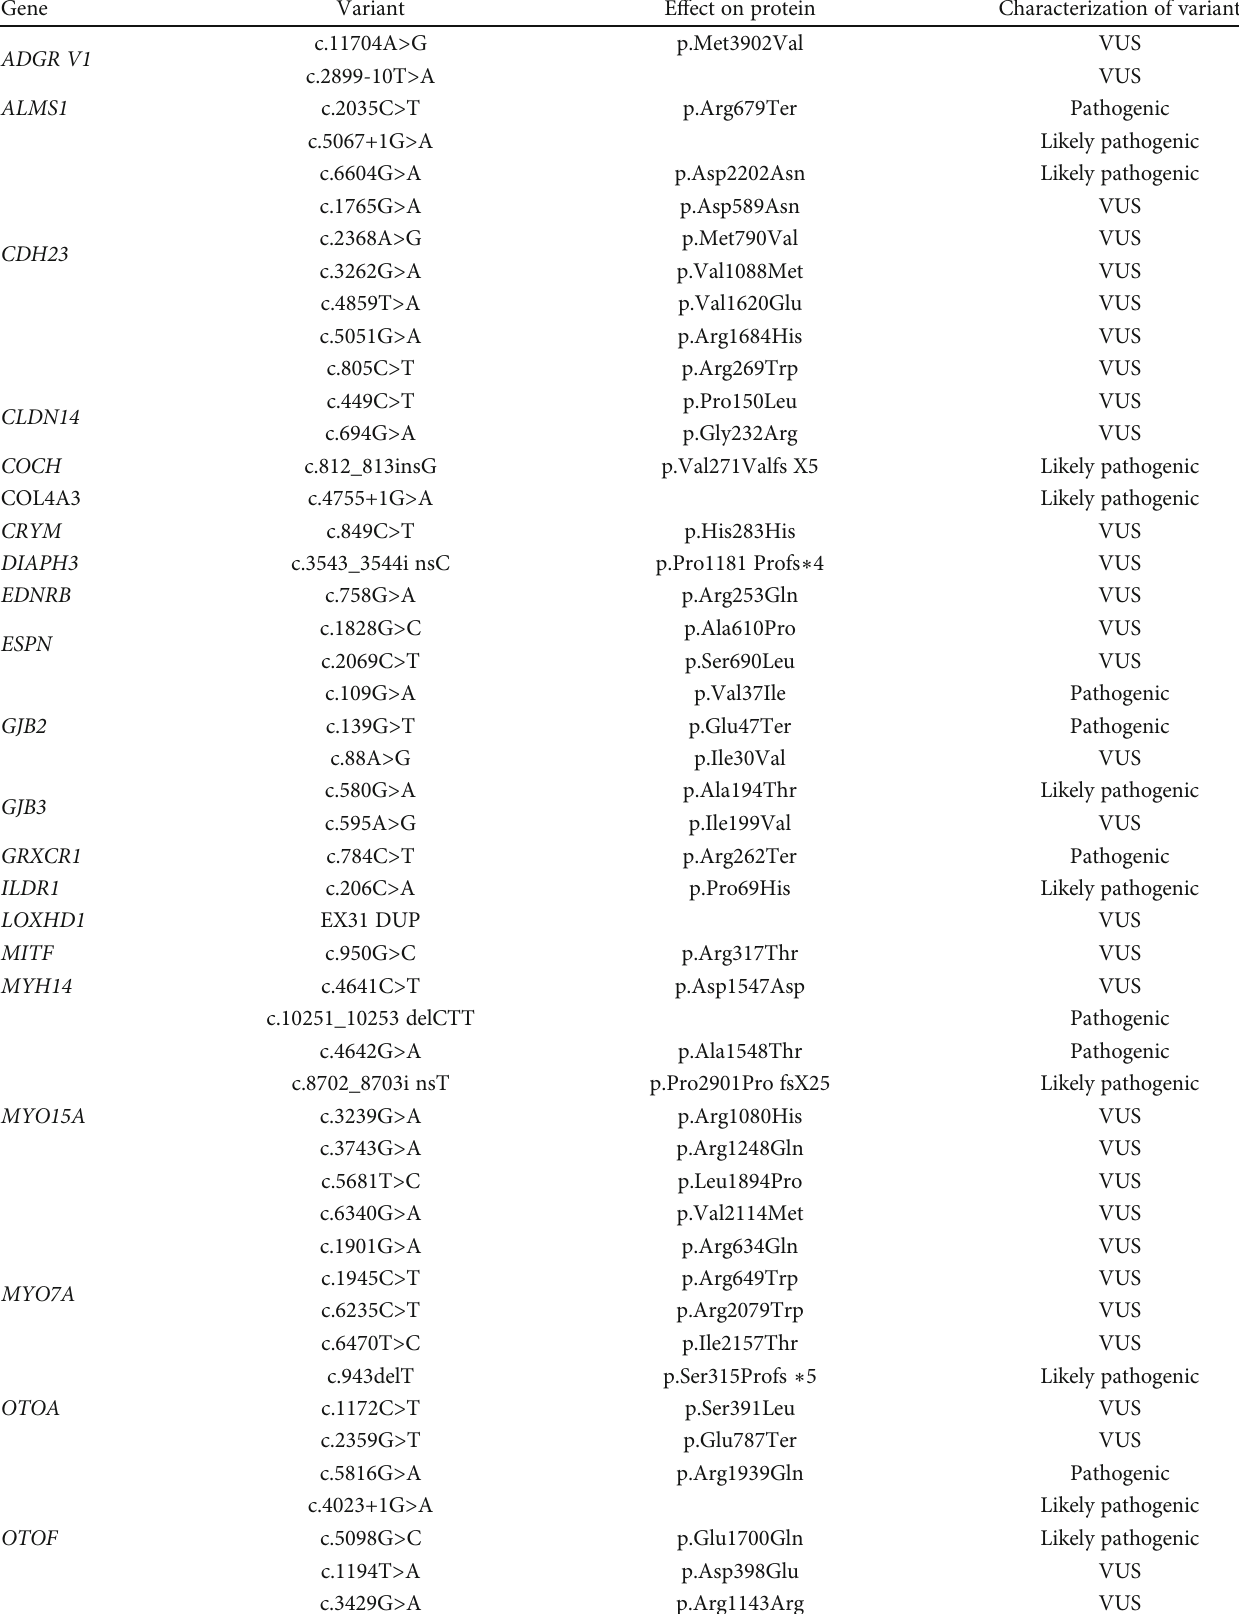
Table 4: The variants would be missed if tested by 159 variant